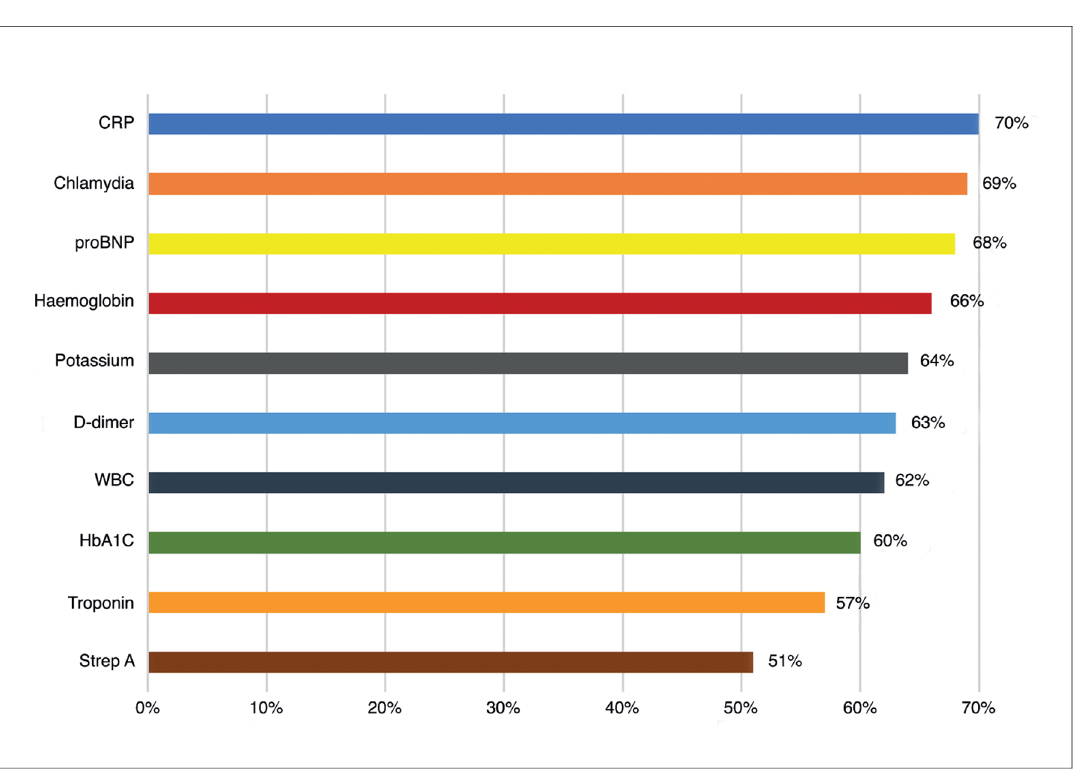
Figure 1. Percentage of GPs who feel that they would use the following POCTs if available in their practice ( n = 132, 92% of total responders). CRP = C-reactive protein. proBNP = N-terminal prohormone of brain natriuretic peptide. Strep A = Group A streptococcus. WBC = white blood